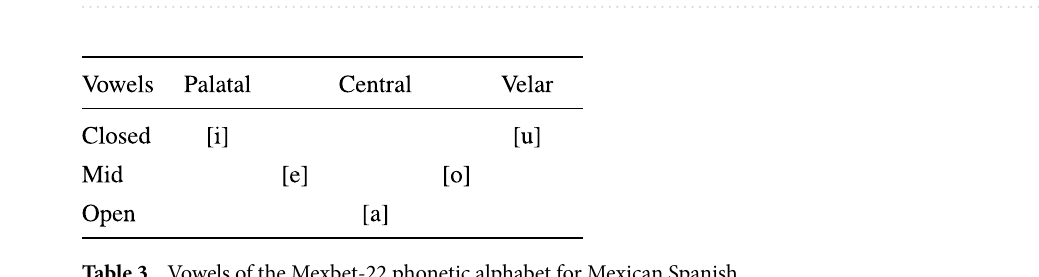
Table 2. Consonants of the Mexbet-22 phonetic alphabet for Mexican Spanish.